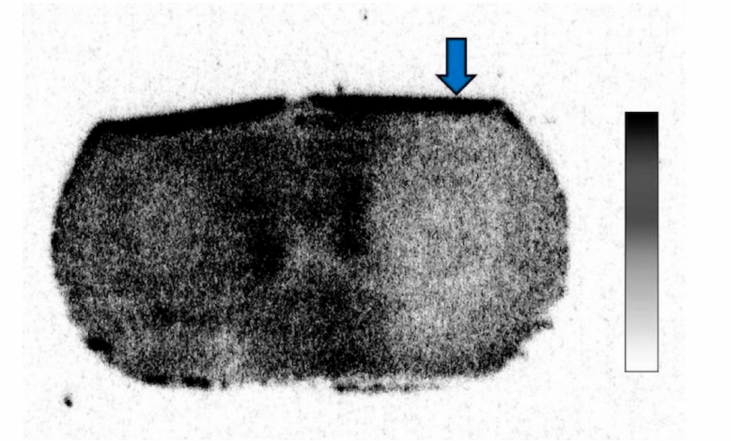
Figure 2. 14 C-acetate autoradiography after fluorocitrate (FC) injection showing decreased uptake in the ipsilateral hemisphere.